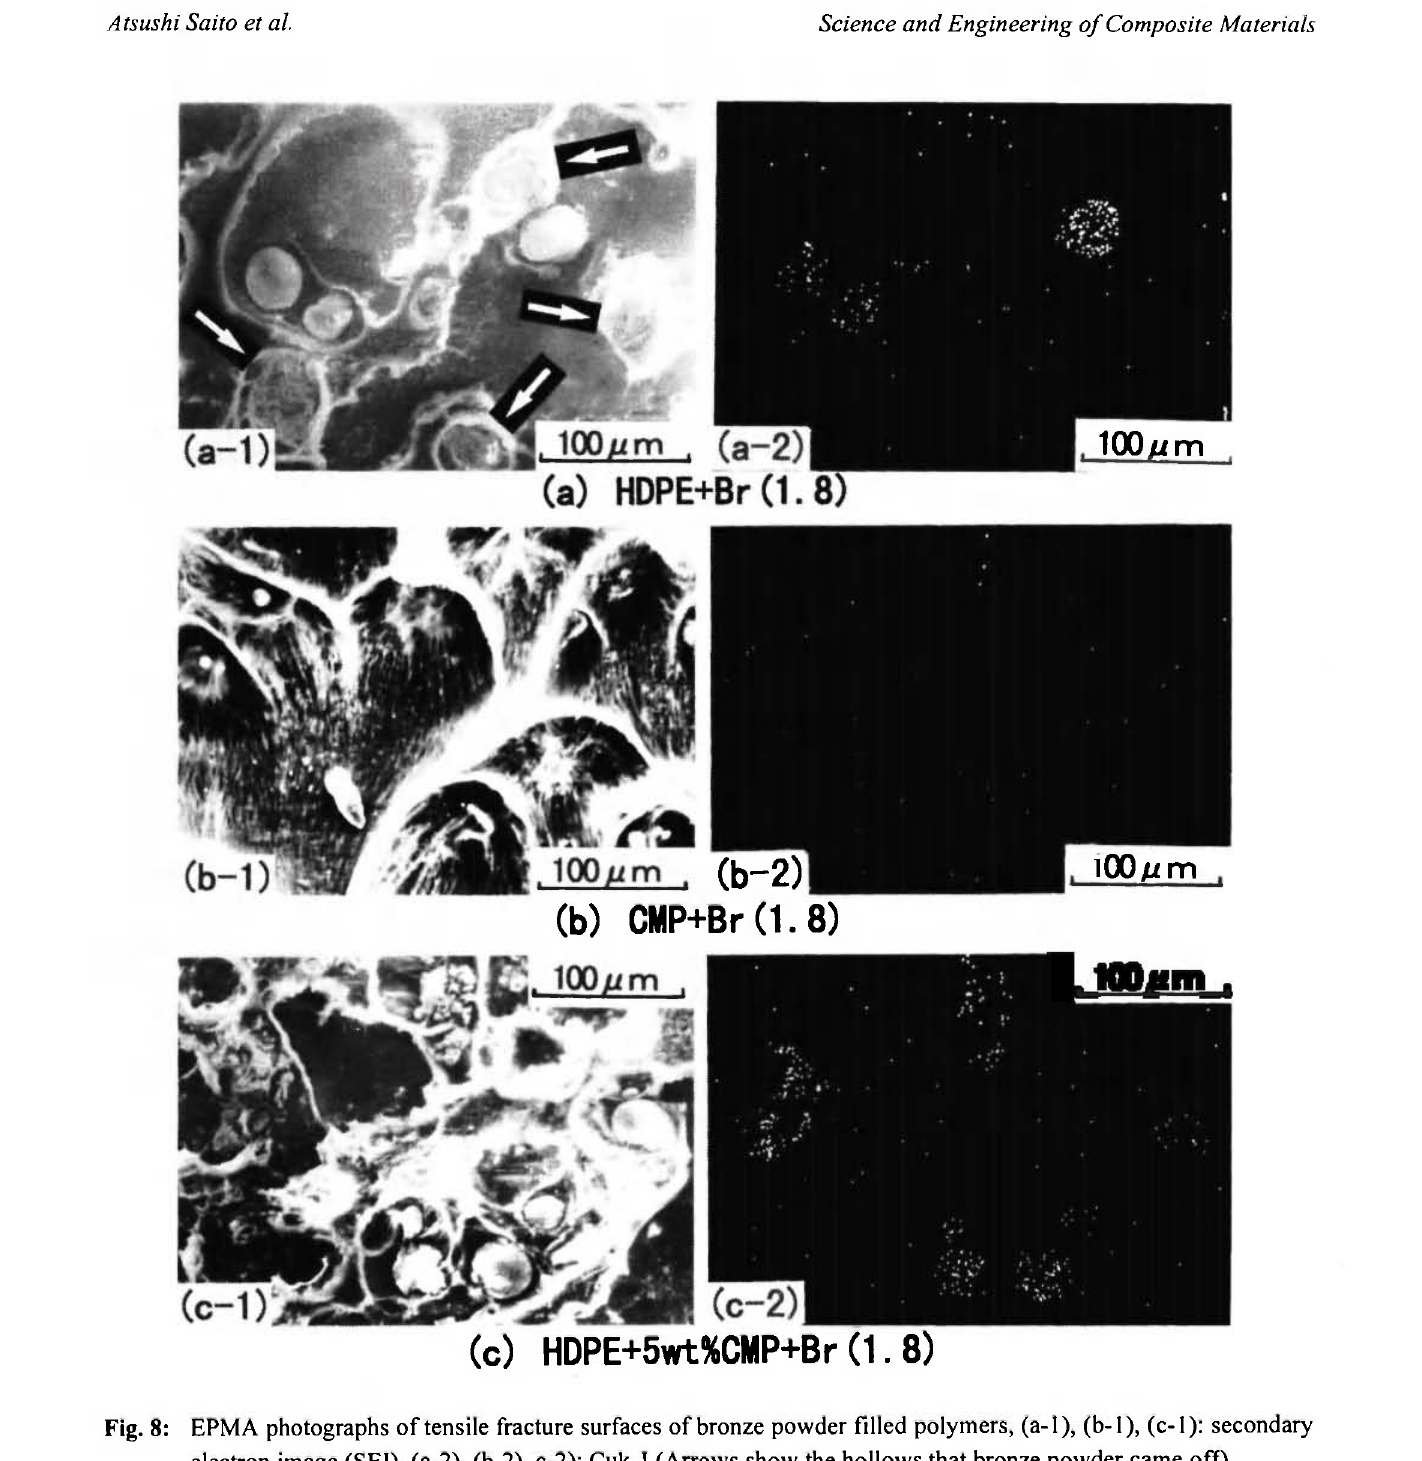
Fig. 8: ΕΡΜΑ photographs of tensile fracture surfaces of bronze powder filled polymers, (a-1), (b-1), (c-1): secondary electron image (SEI), (a-2), (b-2), c-2): Cuk a l (Arrows show the hollows that bronze powder came off)